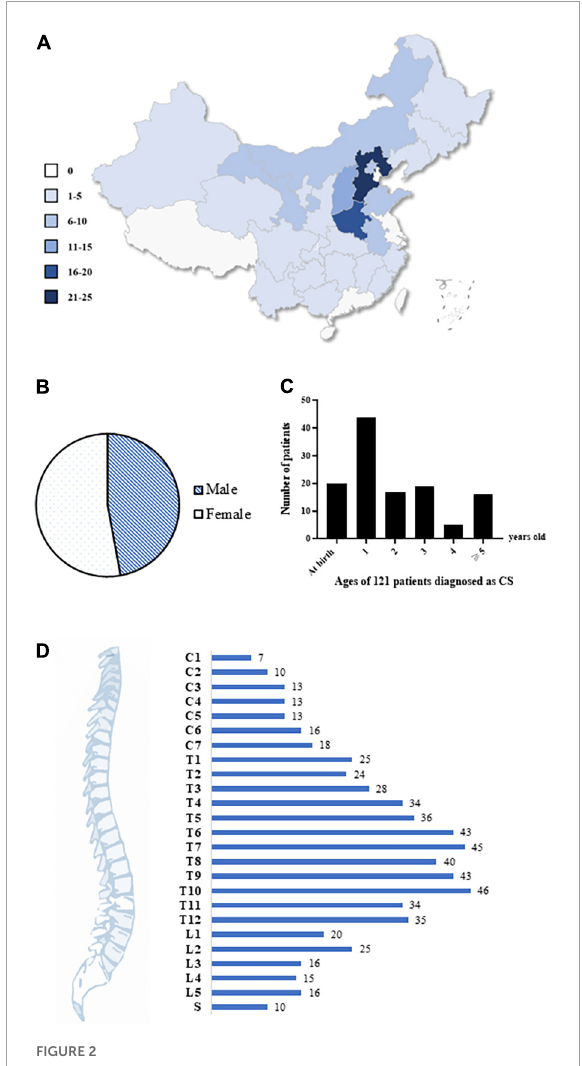
FIGURE2 Demographics and clinical characteristics of the cohort. (A) The geographical characteristic of our cohort. A total of 121 Chinese patients with CS were recruited from all over the country. Different colors represent different patient numbers from the corresponding region, and the darker color, the more patients. (B) The gender ratio. A total of 57 males and 64 females were enrolled. (C) Age of 121 patients when they were diagnosed as CS. 87% of patients were diagnosed with CS before 5 years old. (D) The distribution of malformed vertebrae in all the patients. The numbers of patients were labeled. CS, congenital scoliosis; C, cervical; T, thoracic; L, lumbar; S,